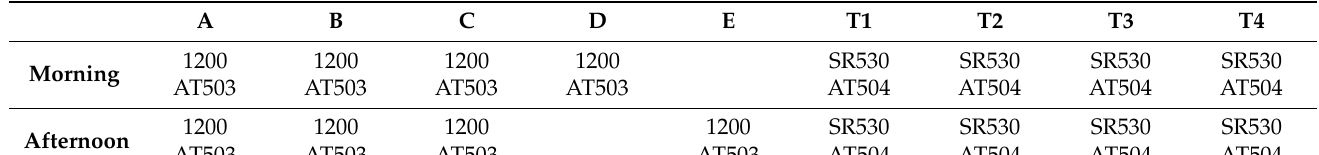
Figure 3. The surrounding environment of GNSS reference station nearby the Severn bridge. Table 1 shows the locations of GNSS antennas for the various sessions. Eight dual- frequency GPS receivers were mounted on the bridge, including four Leica 1200 receivers mounted on the suspension cables and four Leica SR530 receivers mounted on the sup- porting towers. The receiver at location D on morning was moved to the location E on afternoon, due to having only limited number of receivers. The antenna we used for the locations A, B, C, D and E are Leica AT503, and AT504 for the locations of T1, T2, T3 and T4. The two reference receivers and choke ring antennas were Leica 1200 and AT504, respectively. Figure 4 shows the choke ring antenna installation on the bridge suspension cable and tower, respectively. Table 1. Session times, locations and corresponding GNSS receiver types on March 11, 2010.